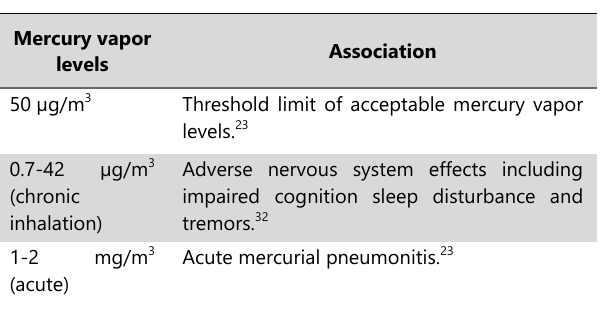
Table 1. Mercury vapor levels and associated medical relevance.